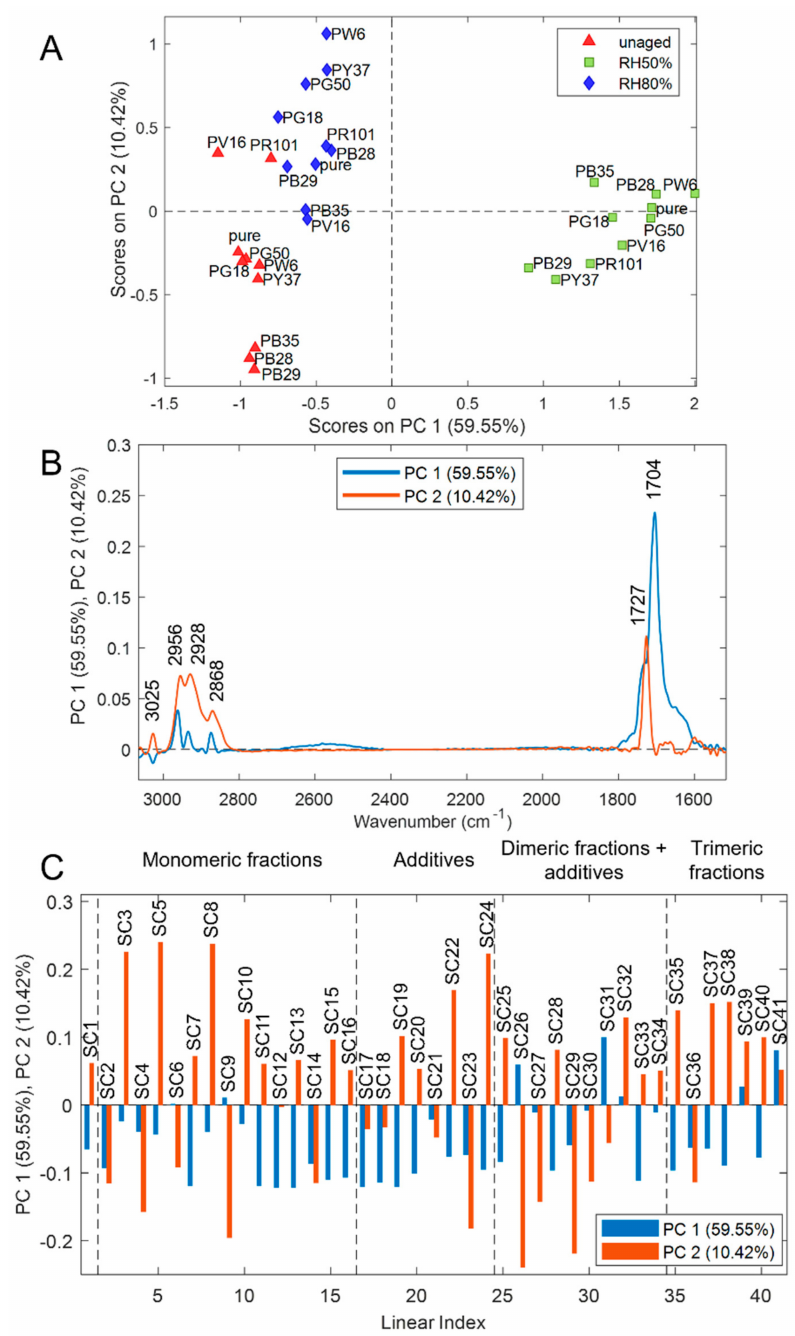
Figure 6. Results of PCA model calculated on FT − , IR and Py − , GC/MS fused dataset of styrene- acrylic samples: ( A ) PC1 and PC2 score plot, ( B ) PC1 and PC2 loadings of FT-IR variables, and ( C ) PC1 and PC2 loadings of Py-GC/MS